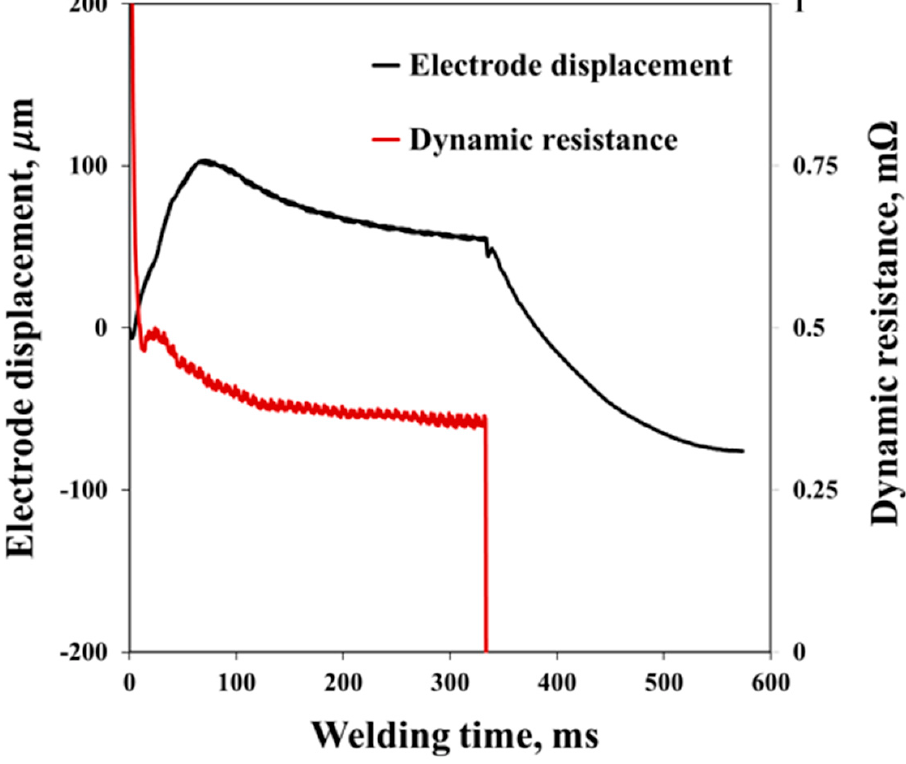
Figure 2. Waveforms of electrode displacement and dynamic resistance during welding process.